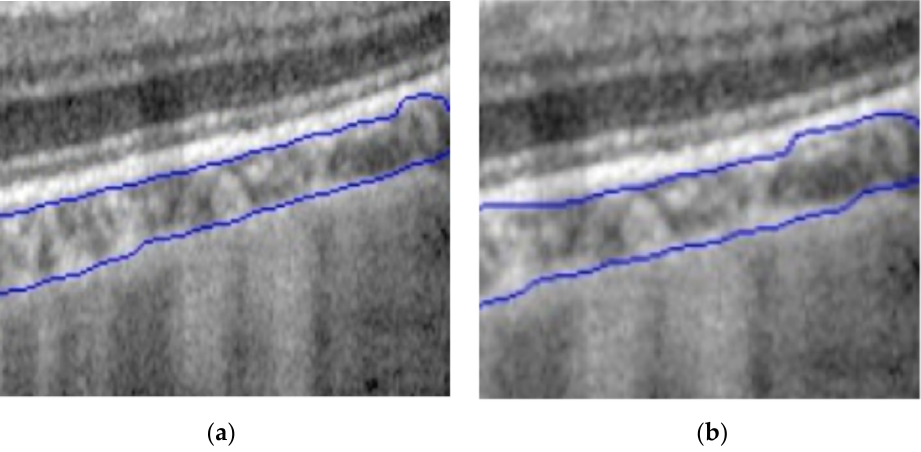
Figure 3. Boundary sketching examples: ( a ) using R101 to generate a rigorous description of the boundary and ( b ) using R50 to generate to generate a rough description of the boundary.